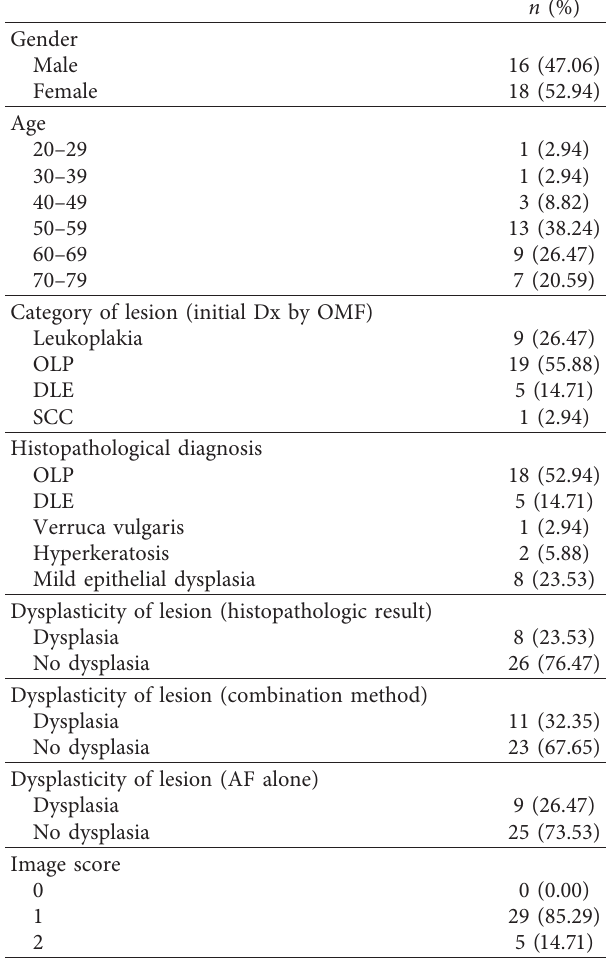
Table 2: Demographic data of patients